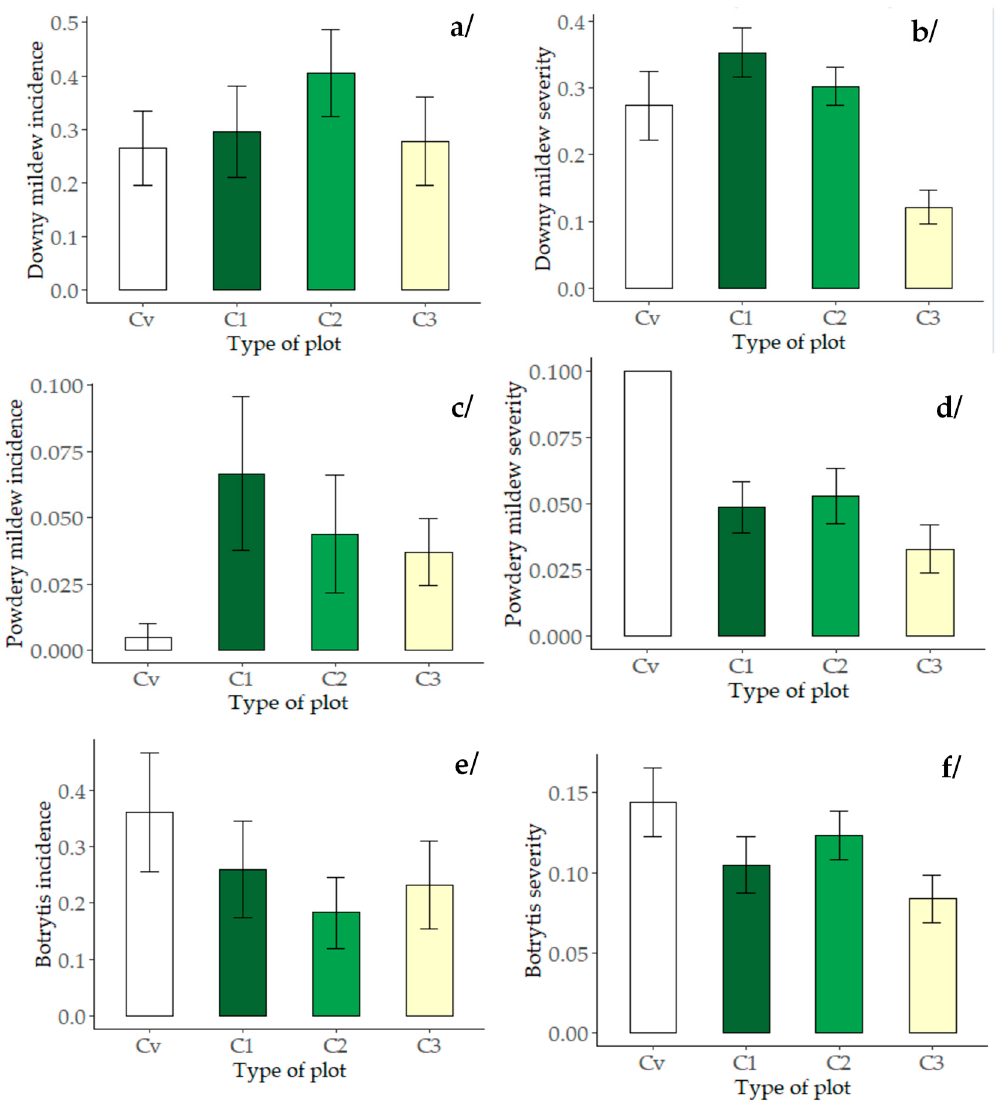
Figure 2. Pathogen incidences and severities in infected plots (downy mildew, powdery mildew, and Botrytis) monitored on the vineyard network depending on the type of plot. ( a ), ( c ) and ( e ): frequency of infected plants per plot (incidence); ( b ), ( d ) and ( f ): severity of each pathogen as measured in infected plots where incidence >0. Error bars represent standard errors.